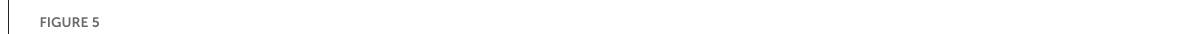
FIGURE5 comparison in the different early feeding strategies. (C) Clustering heat-map of the DEGs, including Ctrl vs. ES (a) , ES vs. ES + EW (b) , and Ctrl vs. ES + EW (c) ; (D) The Venn diagram of all the comparisons and the numbers of DEGs at different early feeding strategies. (E) The KEGG pathways significantly enriched in the unique DEGs identified in the rumen tissue between Ctrl vs. ES (a) , ES vs. ES + EW (b) , and Ctrl vs. ES + EW (c ), and DEGs in main KEGG pathways. The significance of identified KEGG pathways was determined by P < 0.05. (F,G) The relationship between DGEs expression and phenotypic variables, including gene expression related to the development of rumen epithelial morphology of lambs in three groups, n = 6 (F a ) . Correlation heatmap showing the correlation of rumen epithelial morphology and DGEs, n = 6 (F b). Gene expression related to rumen fermentation of lambs in three groups, n = 6 (G a ) ; Correlation heatmap showing rumen fermentation correlated with DGEs, n = 6 (G b ) . The qRT-PCR measurements of the expression of DGEs were analyzed using 2 − 11 CT method.